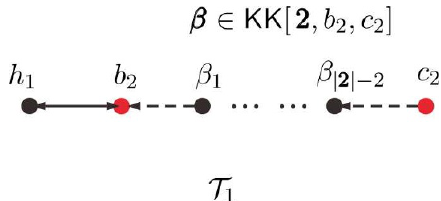
Figure 8 . The graphs (cid:12)gure 7 (a1), (a3) and (cid:12)gure 6 (c) can be reproduced by connecting the structure T 1 with a gluon l 2 f 1 ; 2 ; : : : ; r (cid:0) 1 g = 111 n f r g via a type-3 line. This further implies that the I 1 in eq. (3.7) can be expanded by graph-based BCJ relations (A.13) with T = T 1 . (c) can then be uniformly given by ( k (cid:1) k )( k (cid:1) k ). Let us count the sign: given a h 1 b 2 l b 2 222 ( b 6 = c ) in eq. (3.7), there is an overall sign ( (cid:0) 1) j 222 ;b 2 ;c 2 j which has already 2 2 2 been absorbed into the summation notation with a tilde fP . The sign for each b 2 2 222 b 2 6 = c 2 term inside the square brackets is collected as follows: (1). According to the re(cid:12)ned graphic rule, any graph F with N ( F ) arrows (for both solid and dashed arrow lines) pointing away from the root 1 is associated with a sign ( (cid:0) 1) N ( F ) . (2). Each of (a1) and (a3) has an extra sign ( (cid:0) 1). The above observations further lead to the